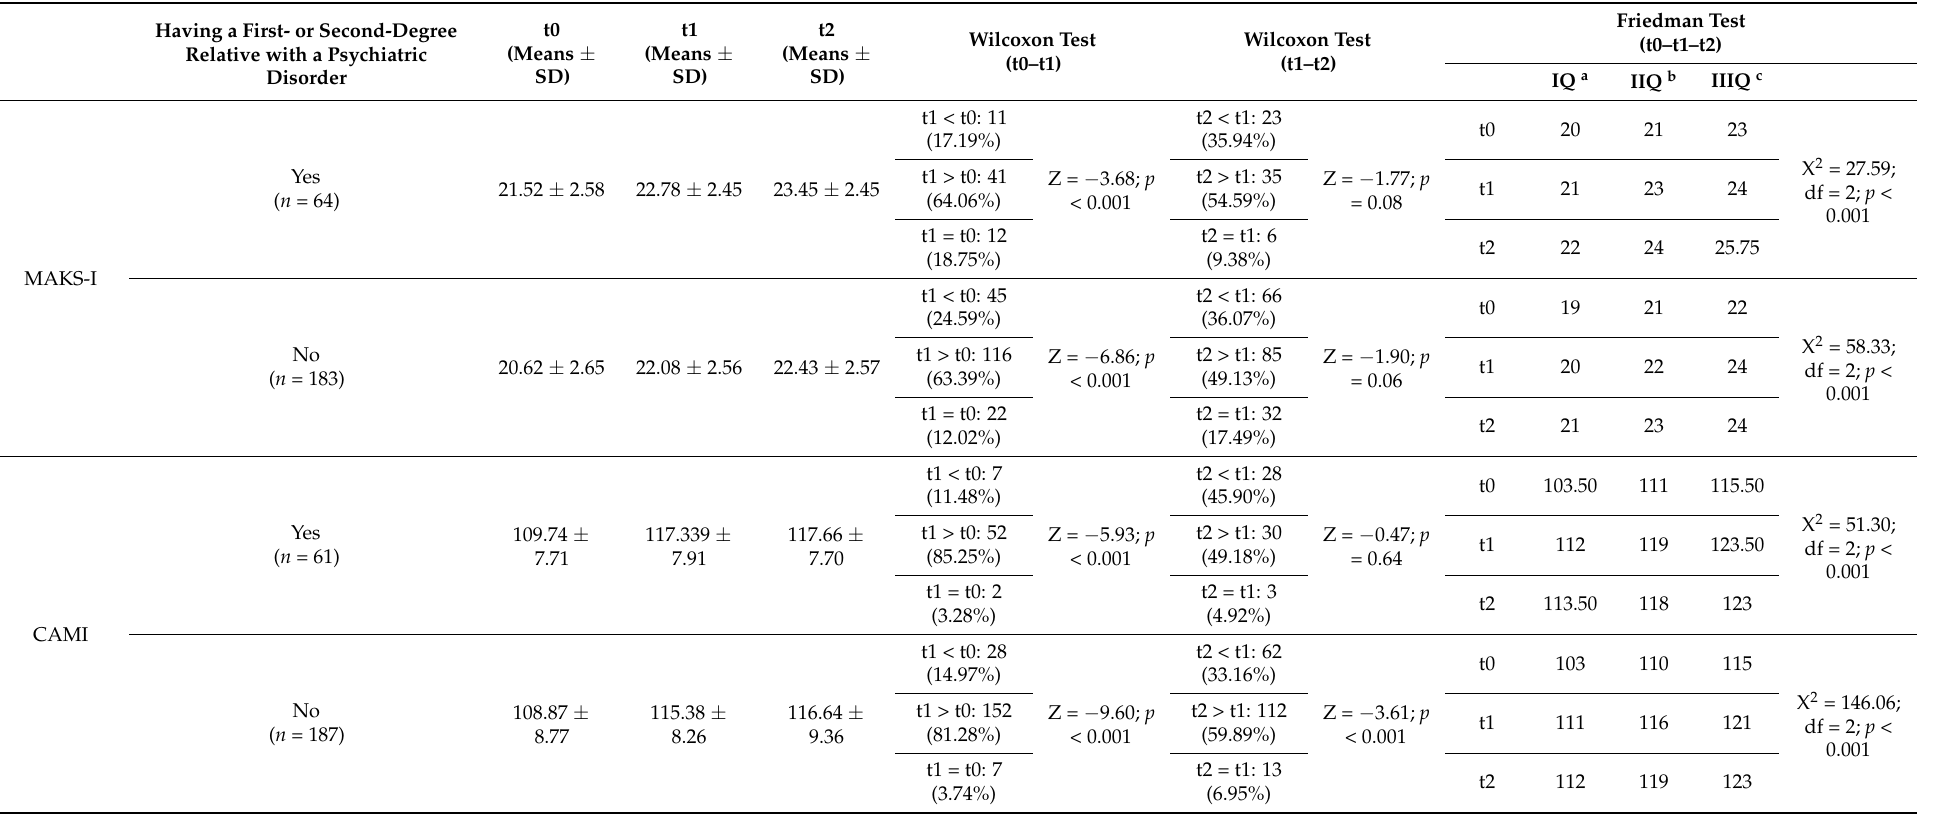
Table 5. Trend over time of the scores obtained in the knowledge of mental disorders (MAKS-I), the attitudes towards people who are mentally ill (CAMI), and the intended behaviour towards people with mental illness (RIBS-I) for students who have/not have a first- or second-degree relative with a psychiatric disorder. Having a First- or Second-Degree Relative with a